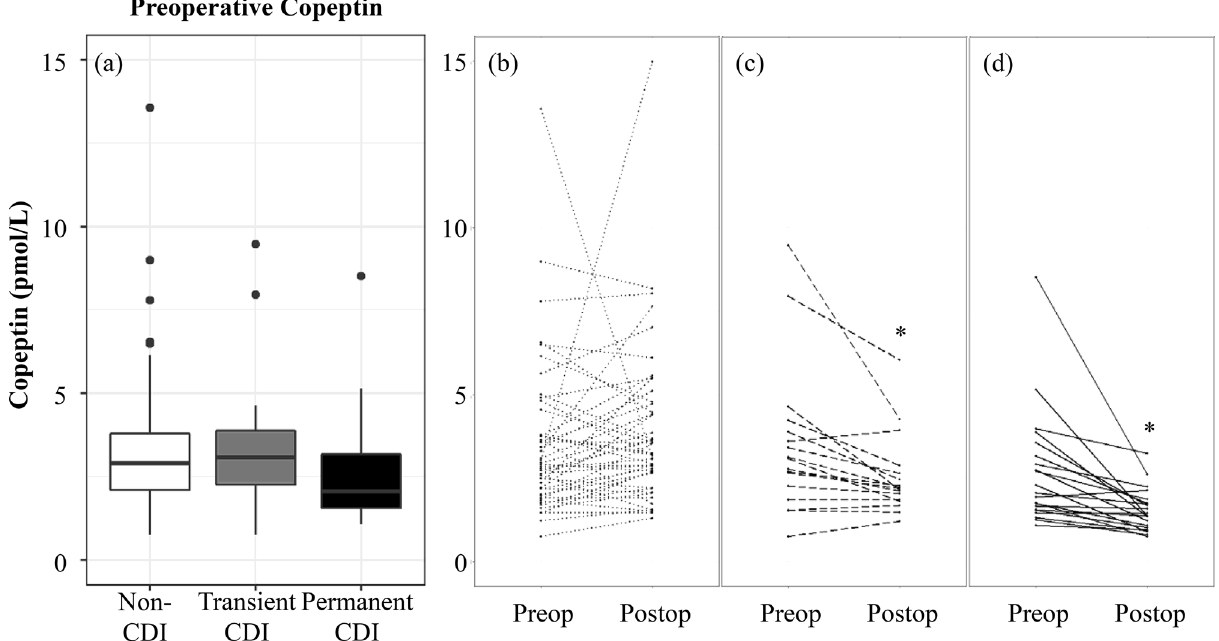
Figure 1. ( a ) Distributions of preoperative copeptin levels and change between preoperative and 3-month postoperative copeptin levels in subjects with ( b ) non-CDI, ( c ) transient and ( d ) permanent CDI. The figures show “Non-CDI,” “Transient CDI,” and “Permanent CDI” in the order from left to right. P -value versus Preop calculated using Wilcoxon signed-rank test was 0.130, 0.002, and < 0.001, respectively. * P < 0.05, versus Preop. Preop, Preoperative; Postop, Postoperative; CDI, Central diabetes insipidus.